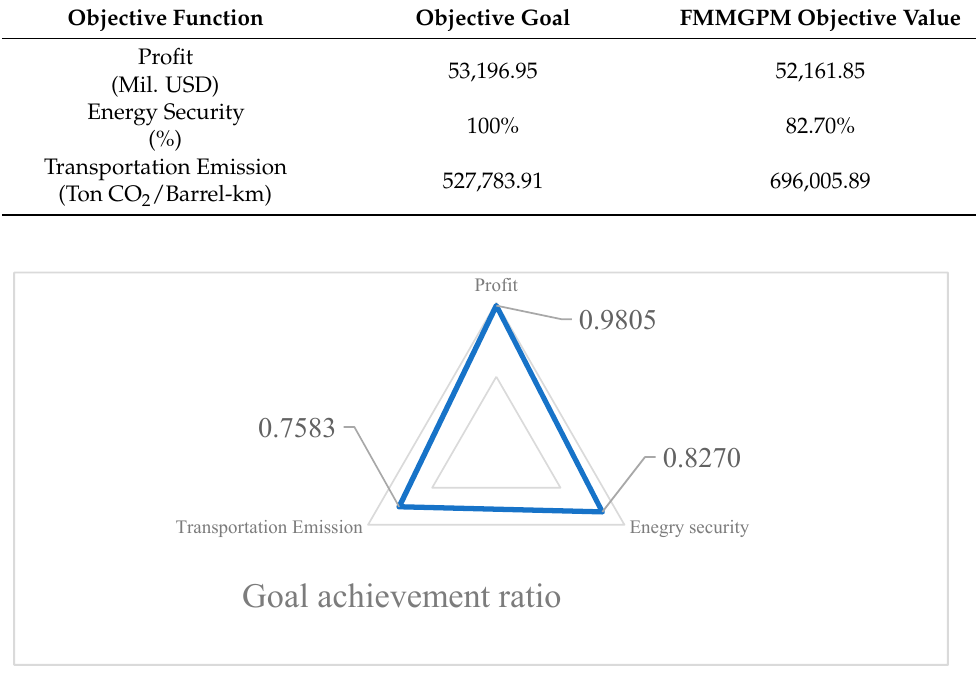
15 of 24 Table 5. Market region center point determination. Market Region